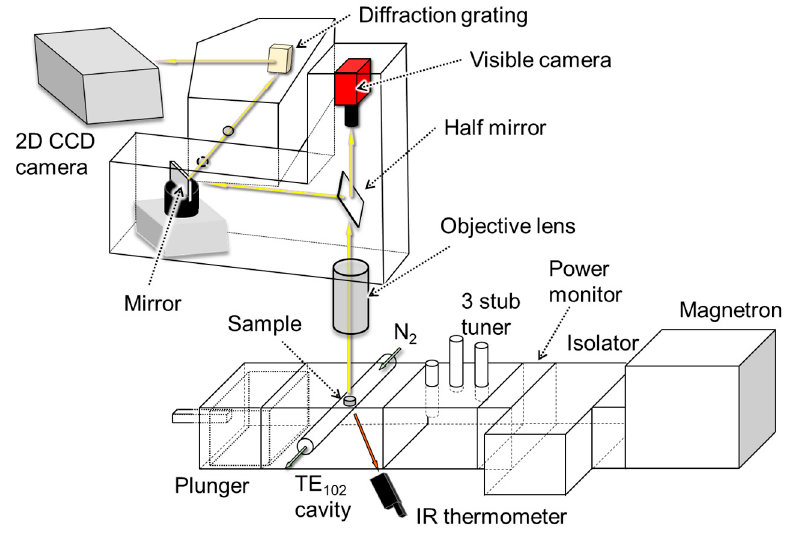
Figure 1. Schematic view of the experimental setup.